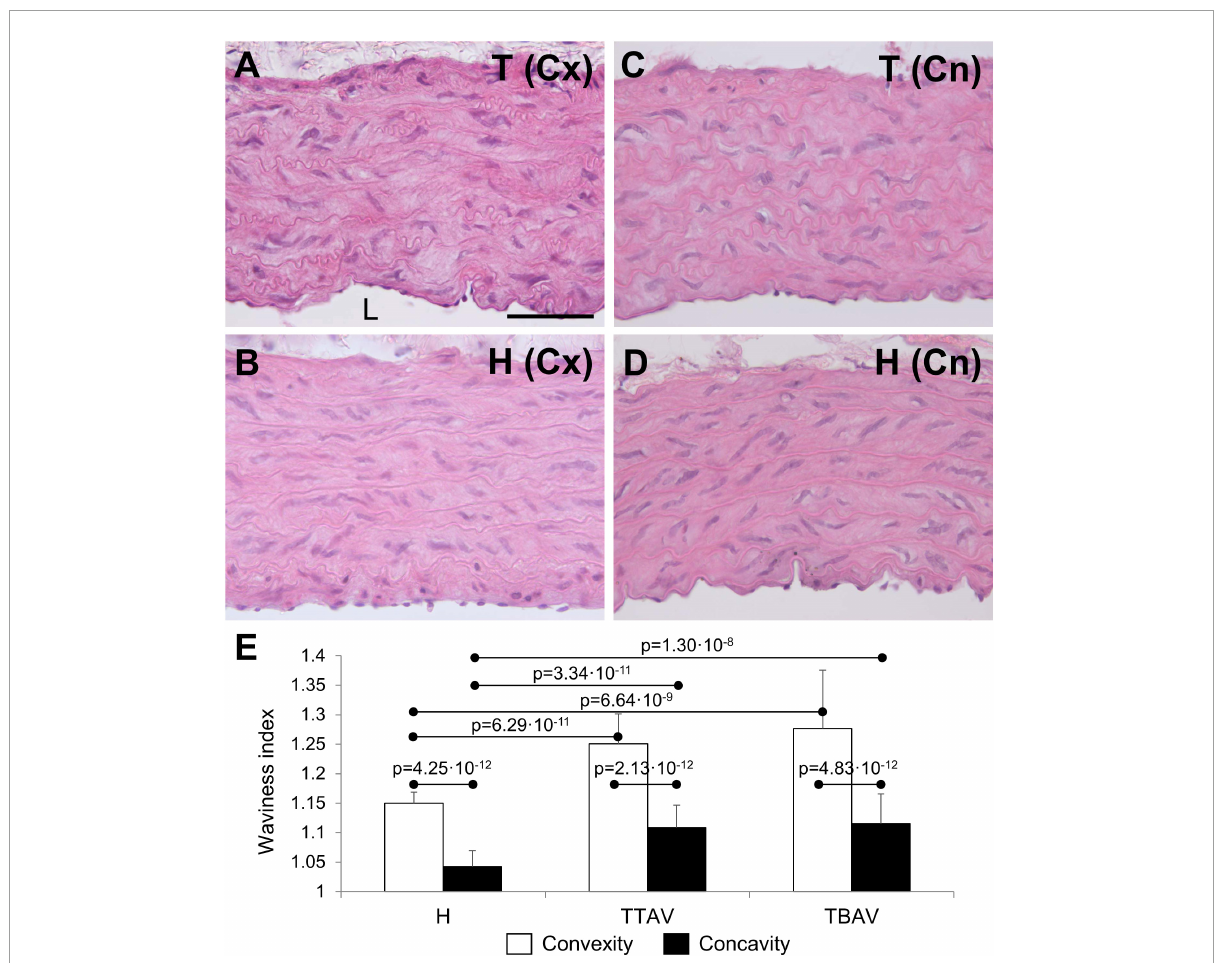
FIGURE2 Transverse sections of the ascending aorta convexity (Cx; A,B ) and concavity (Cn; C,D ) of hamsters from the affected (A,C) and the control (B,D) strains, stained with hematoxylin and eosin. Scale bar: 100 µ m. (E) Quantification of the waviness index in the aortic convexity and concavity of animals from the control strain (H) and from the affected strain with TAV (TTAV) and BAV (TBAV). Only significant p -values are